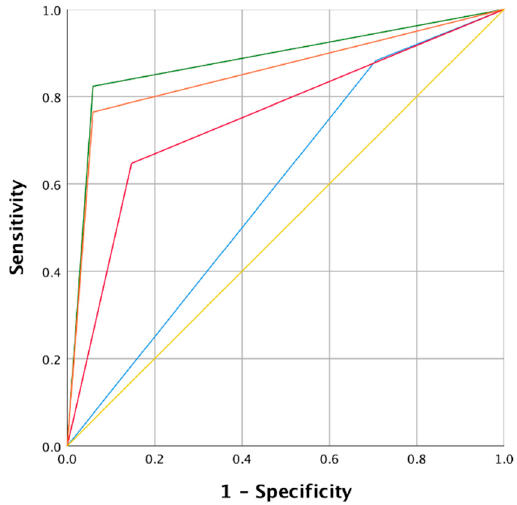
Figure 4. Receiver operating curve (ROC) and area under the curve (AUC) of the four modalities analyzed for group B. Colors of the curves: Green: NBI; Orange: WLE 1 + 2 + NBI; Red: WLE 2; Blue: WLE 1 + 2; Yellow: mean values.